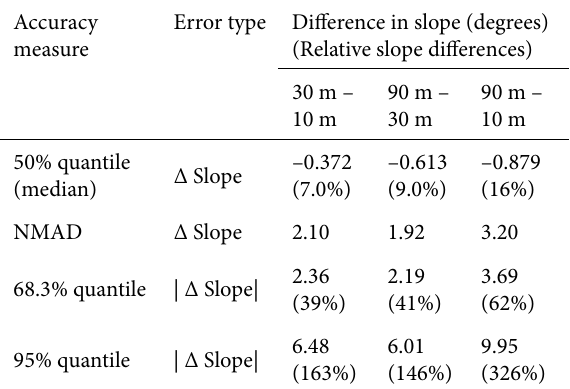
Table 4. Measures of accuracy showing that lower slope values are obtained with lower resolution of the DEM, Sample size is equal to 2310 points Accuracy